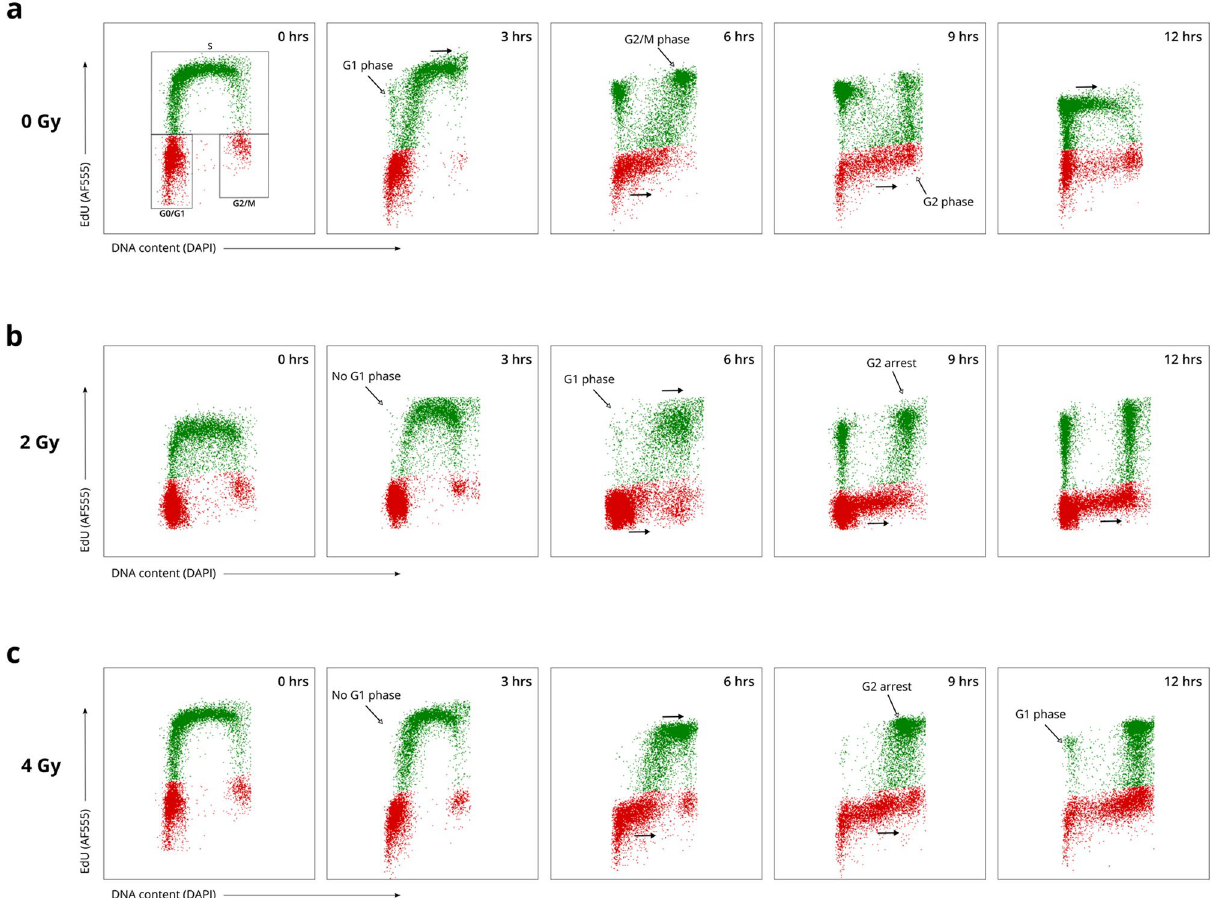
Figure 3. EdU pulse-chasing of T lymphocytes in whole blood cultures allows for the assessment of the cell cycle progression. T lymphocyte proliferation was stimulated with PHA for 96 h before EdU pulse-labeling. ( a ) Bivariate distributions of non-irradiated EdU pulse-labeled T lymphocytes showing DNA content (x-axis) and EdU incorporation (y-axis). The green population shows the EdU-positive T lymphocytes. The red population shows the EdU-negative cells. The black arrows indicate the progression of the cells through the cell cycle, over time. The bivariate profiles of one donor are displayed here. Other donors show similar distributions. ( b ) Bivariate profiles of T lymphocytes exposed to 2 Gy of X-rays, visualized as described for (a). ( c ) Bivariate profiles of T lymphocytes exposed to 4 Gy of X-rays, visualized as described for